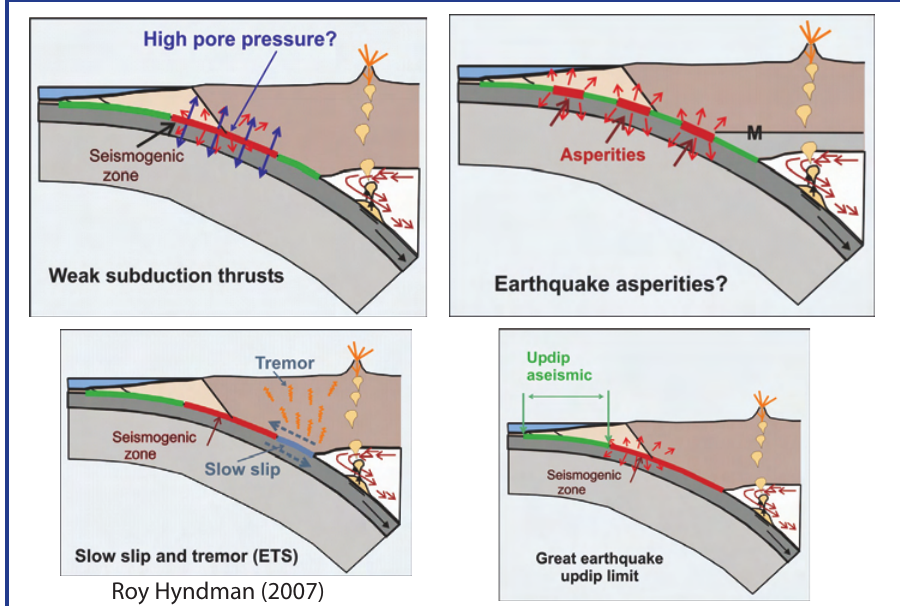
Roy Hyndman Figure 3 . Similar questions to fault zone drilling (Modified from Hyndman, 2007)